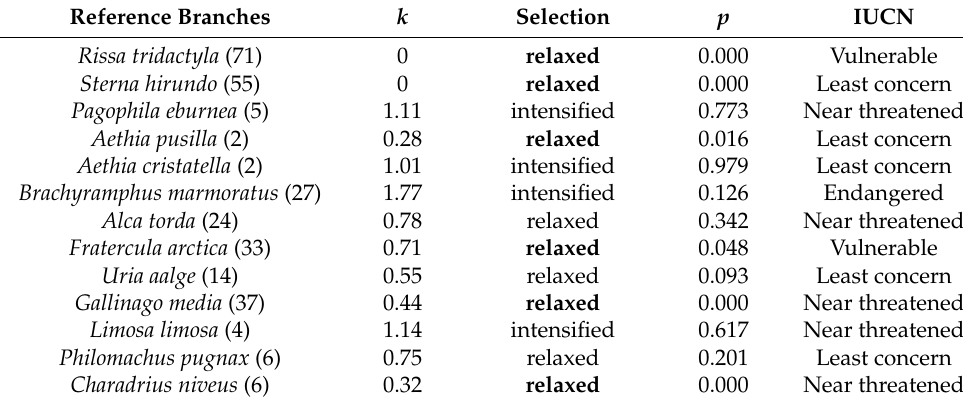
Table 3. Estimates of the selection intensity ( k ) recovered with the RELAX approach. Effects of intensified ( k > 1) or relaxed ( k < 1) selection were inferred for the MHCIIB variants of Heermann’s Gull (near threatened) from this study, comparing it separately with homologous sequences for thirteen species of Charadriiformes in GenBank as reference branches. Significant effects are shown in bold ( p < 0.05). The International Union for Conservation of Nature (IUCN) red list category is shown for each species. Reference Branches